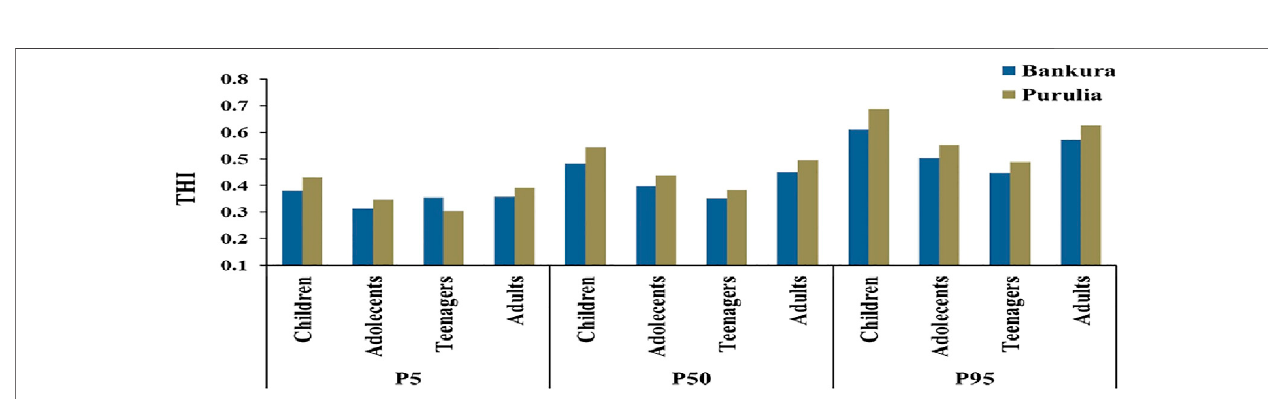
FIGURE 5 | Total Hazard Index (THI) determined at P5, P50, and P95 by a probabilistic health risk assessment of fl uoride exposure at four different age groups in different cultivated crops from Bankura and Purulia.